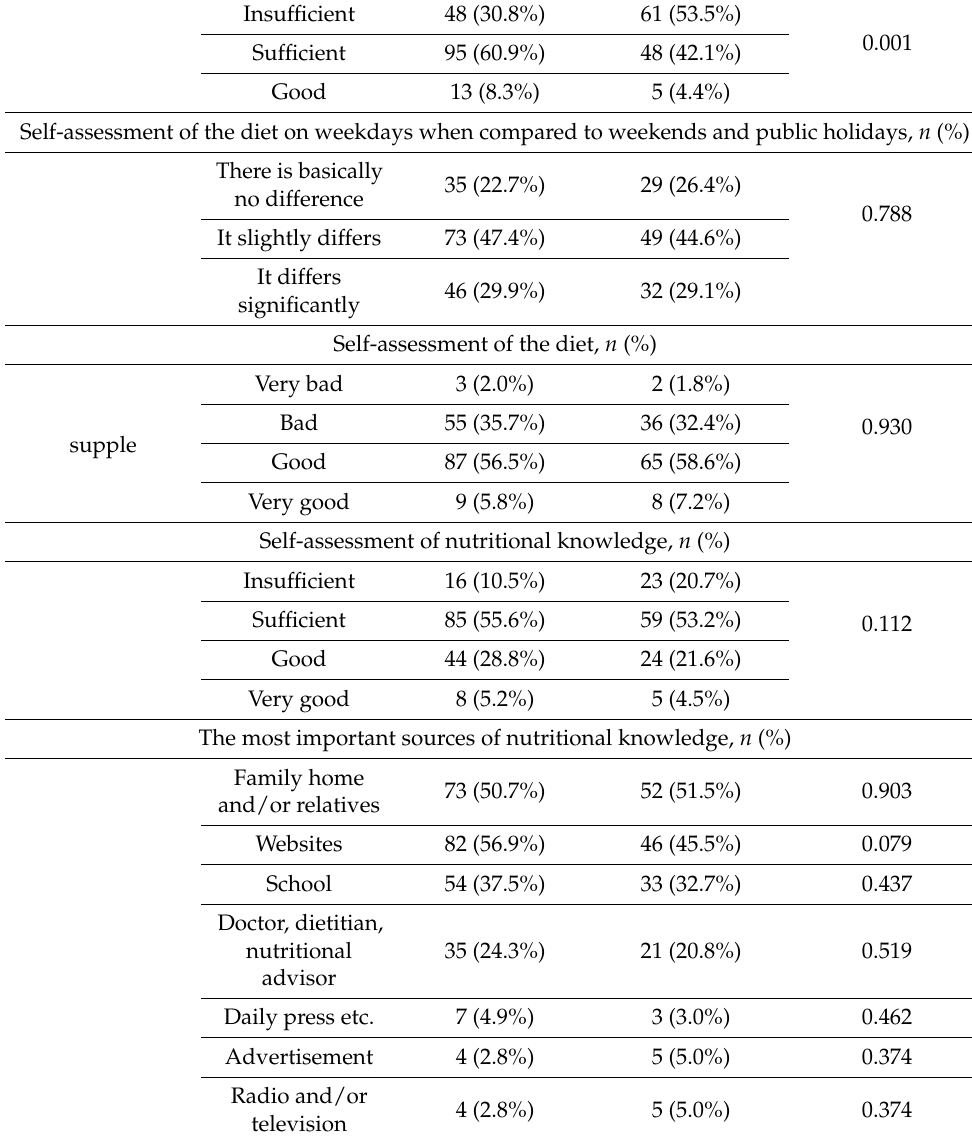
Table 3. Women and men’s level of nutritional knowledge, self-assessment of the diet and nutritional knowledge and its sources. Sex p -Value Variables Female Male The level of nutritional knowledge, n (%) Insufficient 48 (30.8%) 61 (53.5%) 0.001 Sufficient 95 (60.9%) 48 (42.1%) Good 13 (8.3%) 5 (4.4%) Self-assessment of the diet on weekdays when compared to weekends and public holidays, n